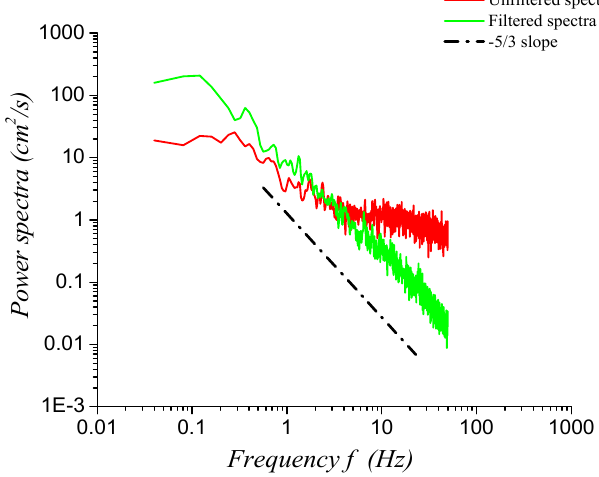
Figure 3. Power spectra of raw as well as filtered velocity time series.